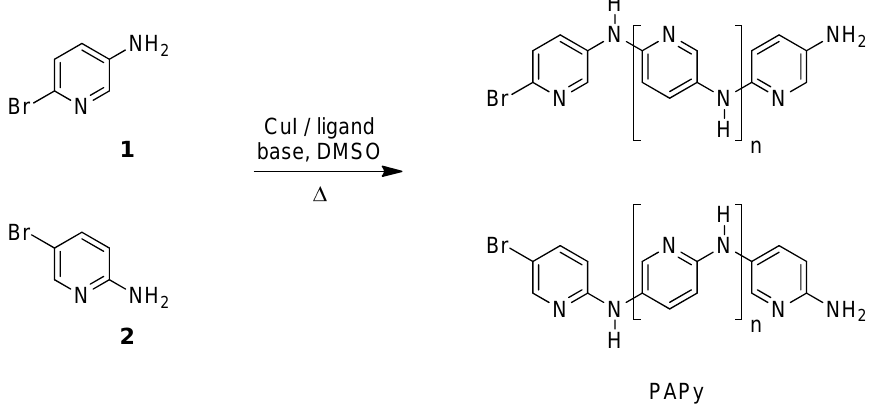
Table 1. Experimental conditions used in PAPy preparation and observed M